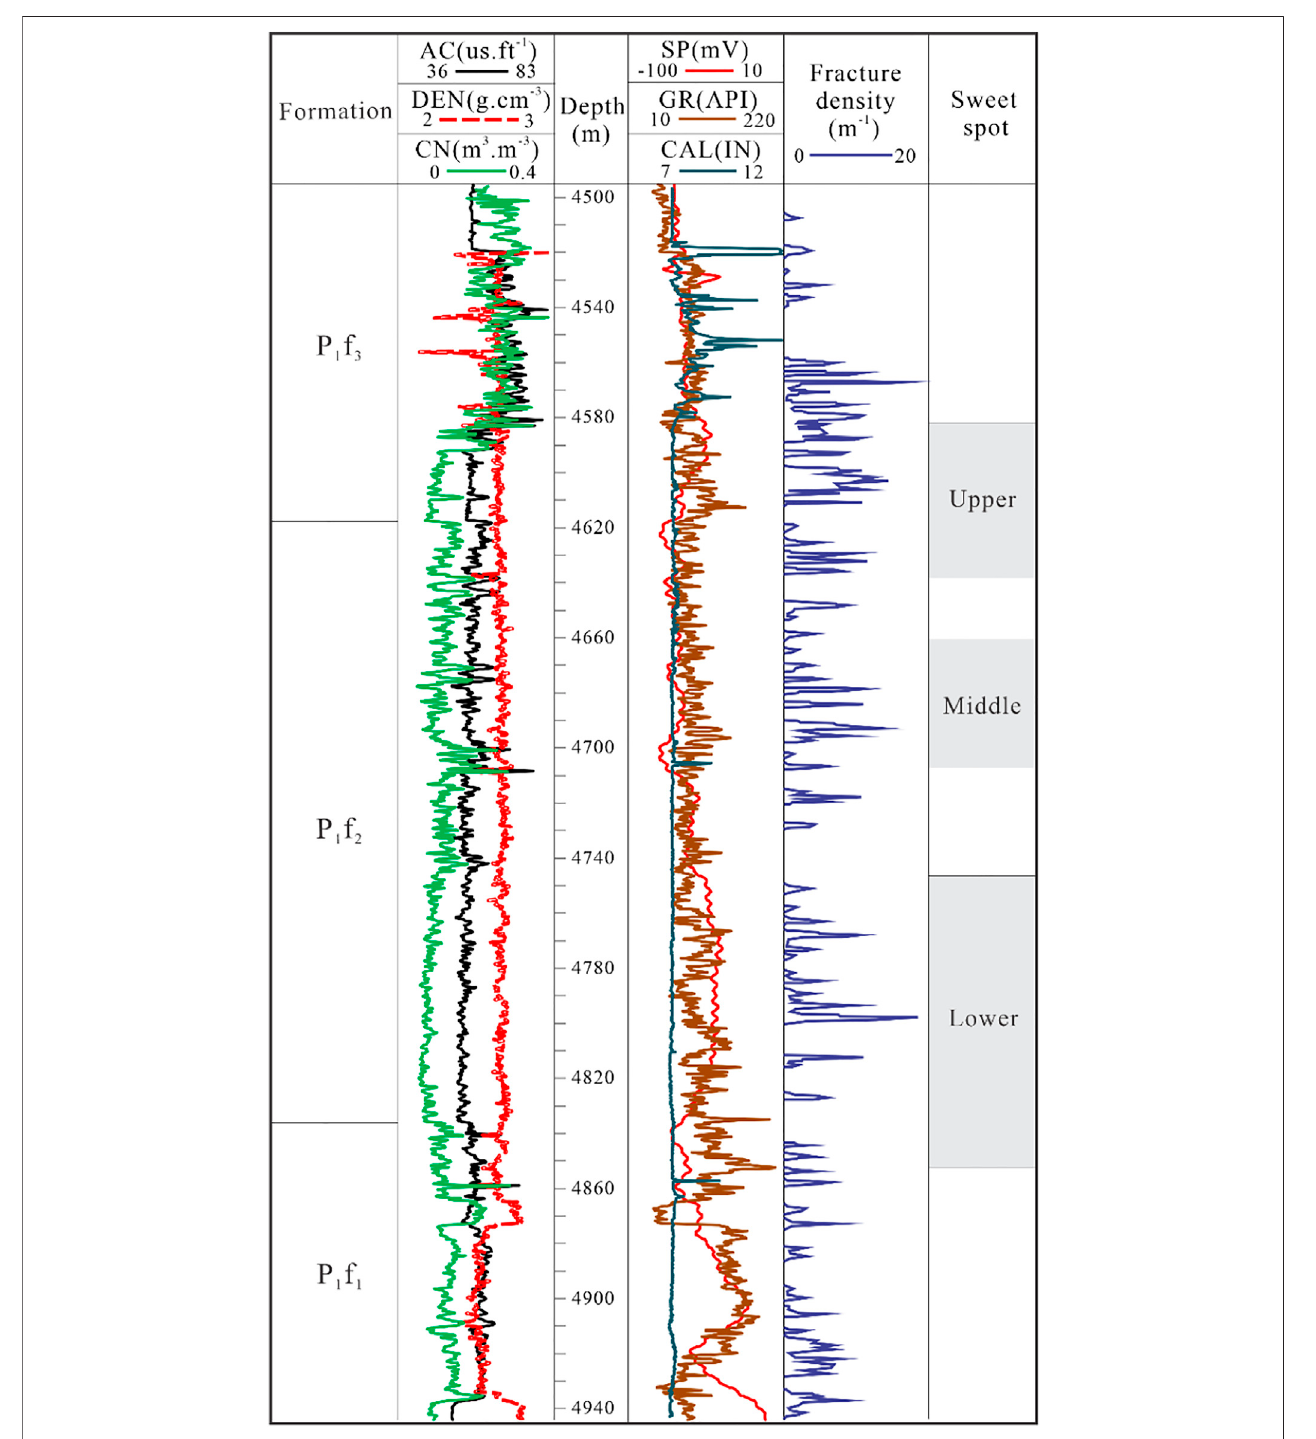
FIGURE 7 | Histogram of fracture identi fi cation in the upper sweet spot of well B2.